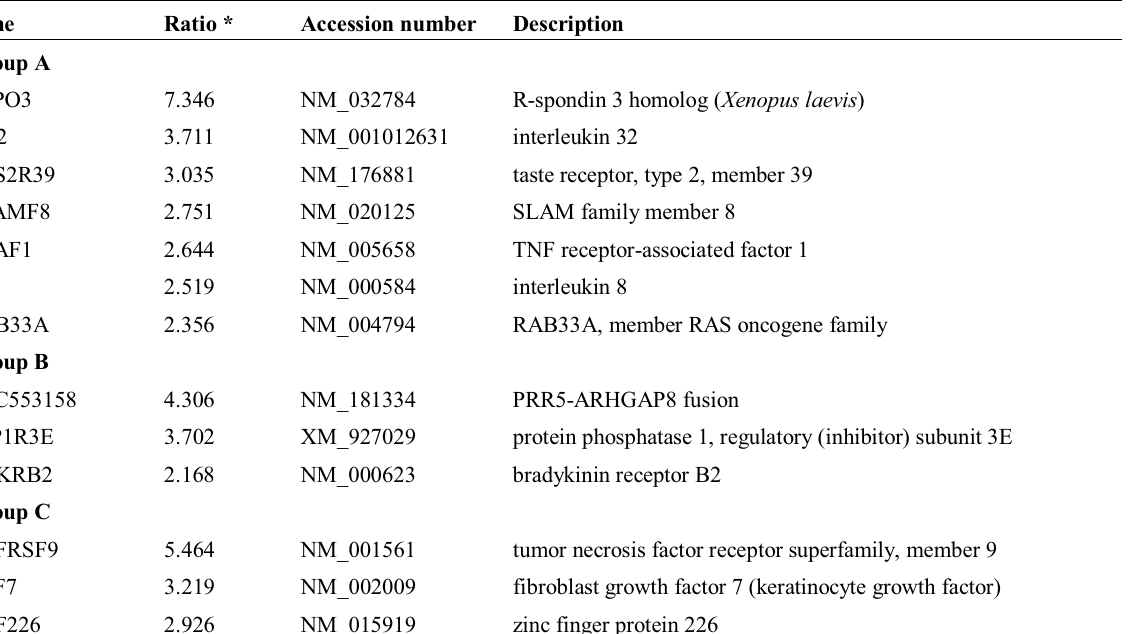
Table 4. Genes encoding receptors, signal proteins, transcription factors, cytokines, and growth factors whose expression was high at pH